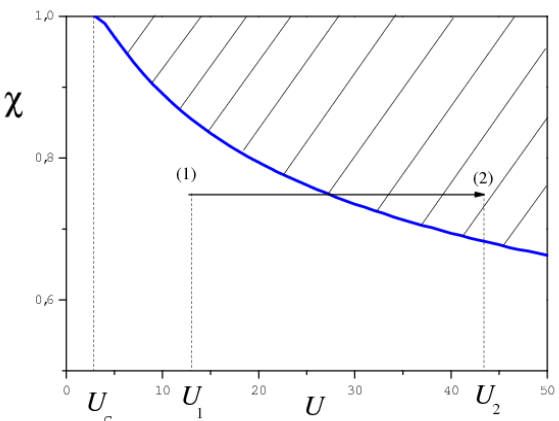
Figure A1. The instability area (shaded) in the coordinates ( U , χ ) . Point (1) corresponds to the initial extension rate close to the die in the fiber spinning process and (2) is the final point where the external tension force is applied.